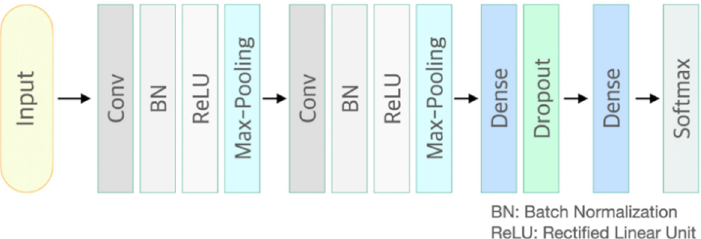
Figure 2. Functional structure of the proposed convolutional neural network architecture. Conv: convolutional neural network layer; BN: batch normalization layer; ReLU: rectified linear unit activation; Max-Pooling: max pooling layer; Dropout rate = 0.5.